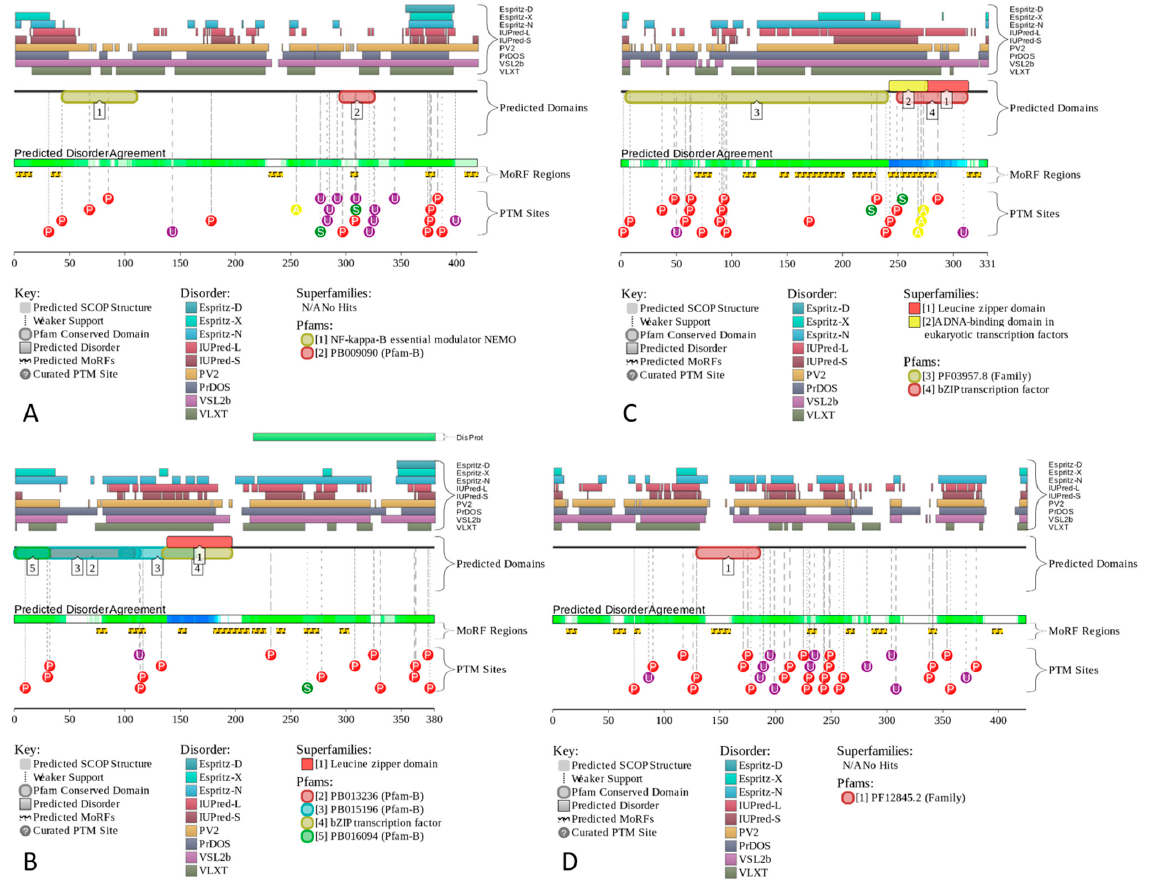
Figure 6. The functional disorder profiles generated for IKK γ ( A ), c-FOS ( B ), Jun ( C ), and TANK ( D ) using the D 2 P 2 platform (http://d2p2.pro/ accessed on 7 July 2022). In addition to the outputs of nine disorder predictors, the positions of the conserved functional domains, consensus disorder score, and positions of the various PTMs, this plot also includes the locations of the predicted disorder-based binding sites (MoRF regions) identified by the ANCHOR algorithm [157] (shown by the yellow zigzagged bars).